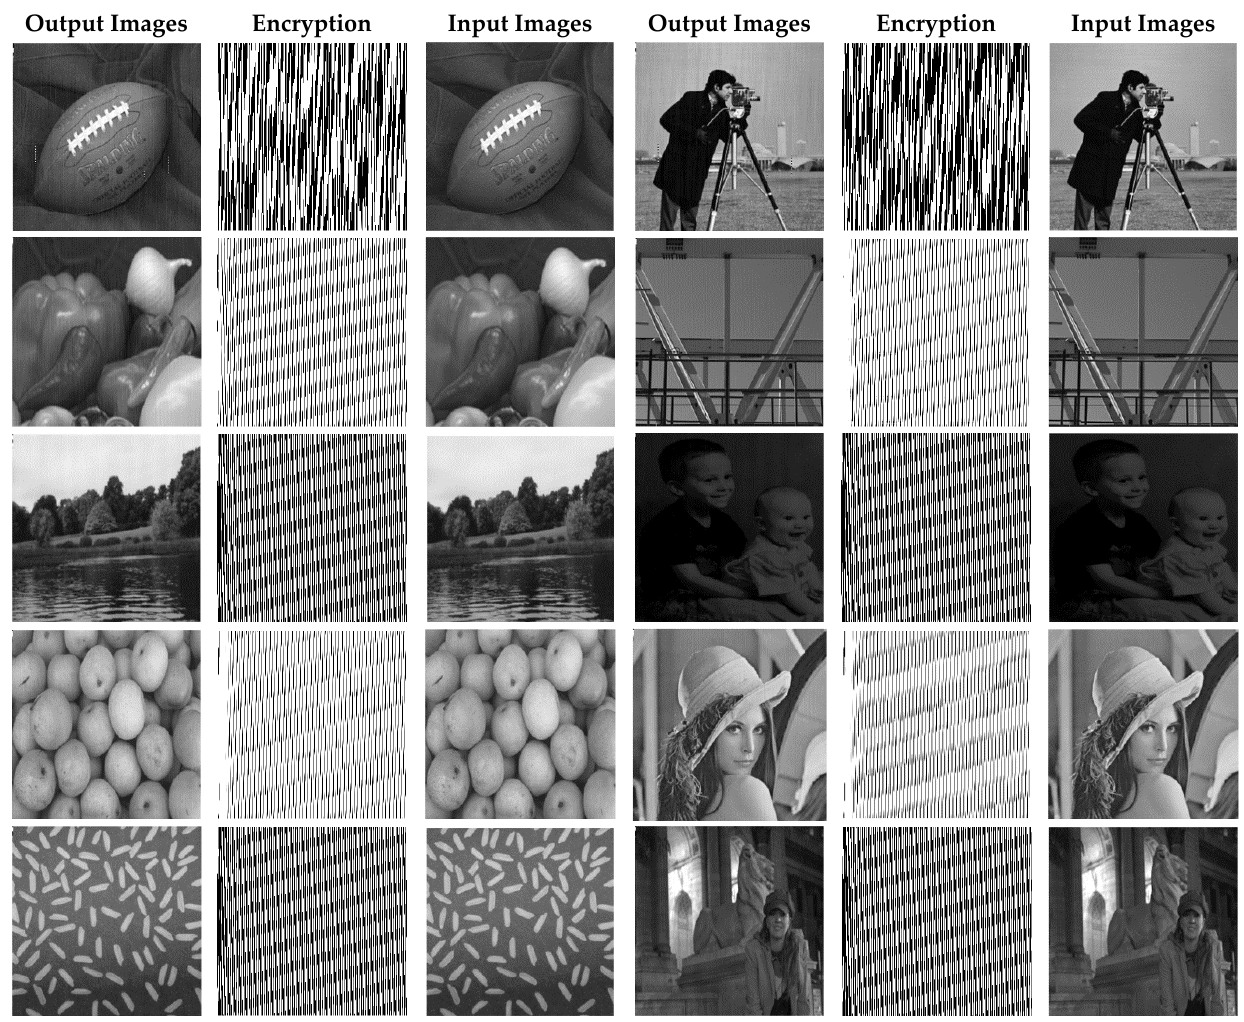
Figure 14. Standard benchmarks images encryption using the proposed method. In Figure 15, X-ray images of patients with COVID-19 for cryptography are